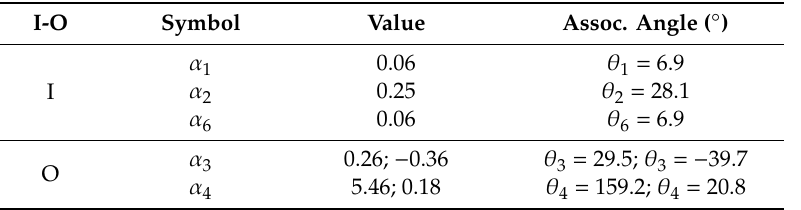
Table 2. Solutions for the 6R closed loop mechanism.